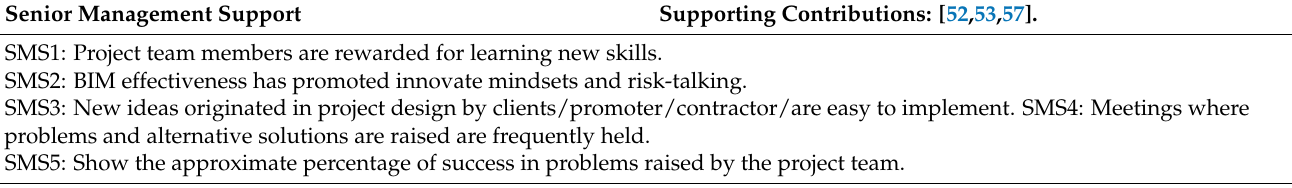
Table 1. Variables